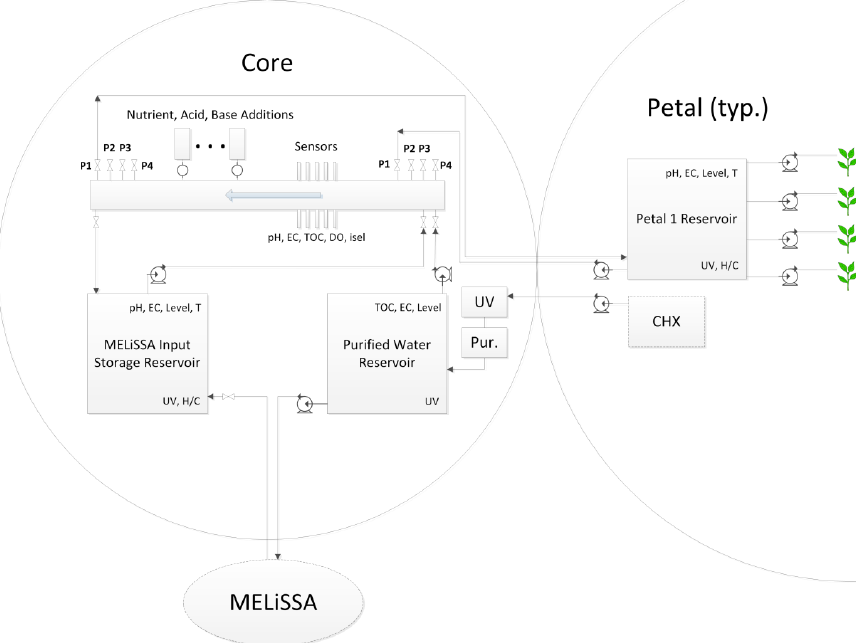
Figure 10: Top-level concept of the NDS (EC – Electrical Conductivity, TOC – Total Organic Carbon, DO – Dissolved Oxygen, isel – Ion Selective Sensor, Level – Level Sensor, T – Temperature Sensor, H/C – Heating and Cooling System, Pur. – Purification System, CHX – Condensing Heat Exchanger, P1 … P4 – Pump).